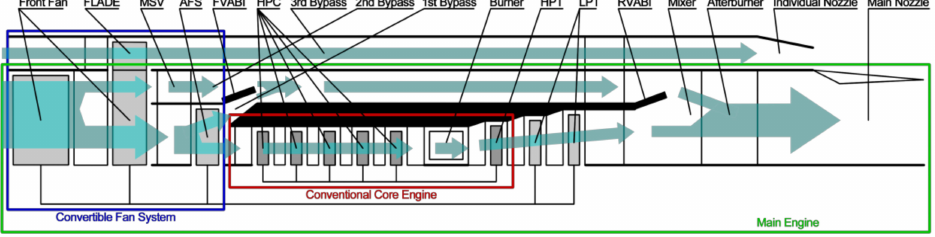
Figure 1. The Simplified Cross Section of Configuration and Flow Paths of Adaptive Cycle Engine with Convertible Fan